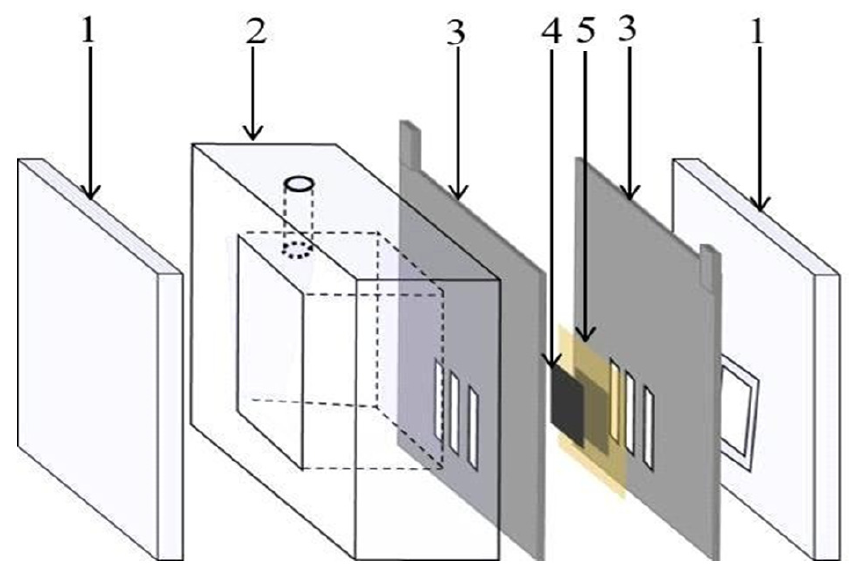
Figure 1. A schematic diagram of the cell structure: 1—Cover plates, 2—Anode chamber, 3—Current collectors, 4—Anode, and 5—Membrane and cathode.